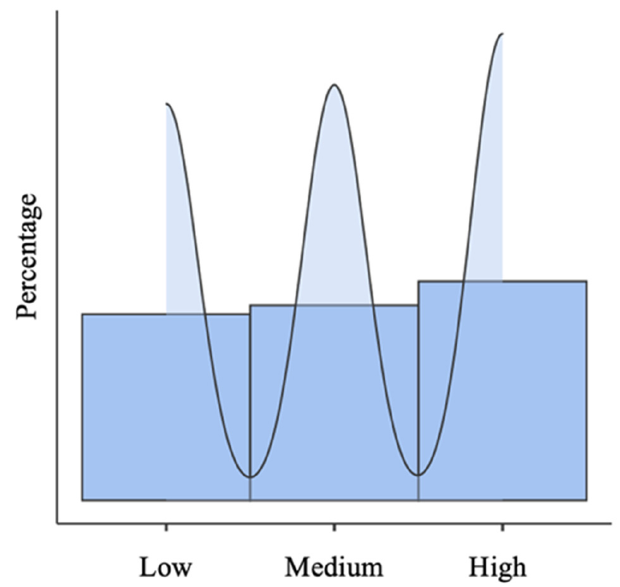
Figure 1. Percentage of the prevalence of state anxiety in children and adolescents ( n = 953).